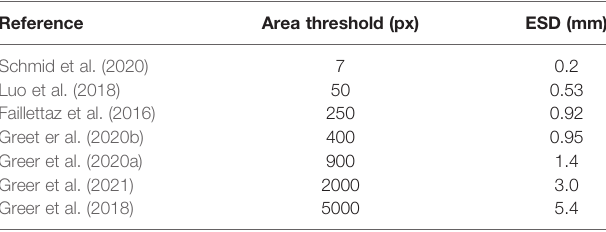
TABLE 1 | Threshold in object area (number of pixels considered as part of the object) in studies exploiting ISIIS